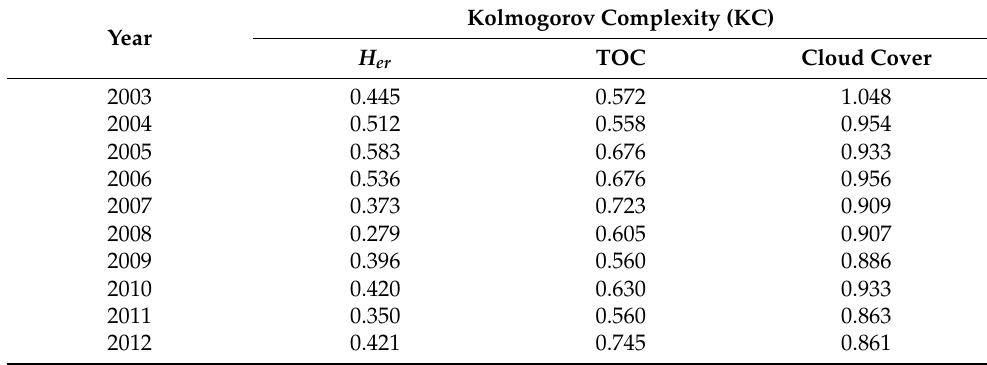
Table 1. Kolmogorov complexity (KC) of daily H er , TOC, and cloud cover time series in Novi